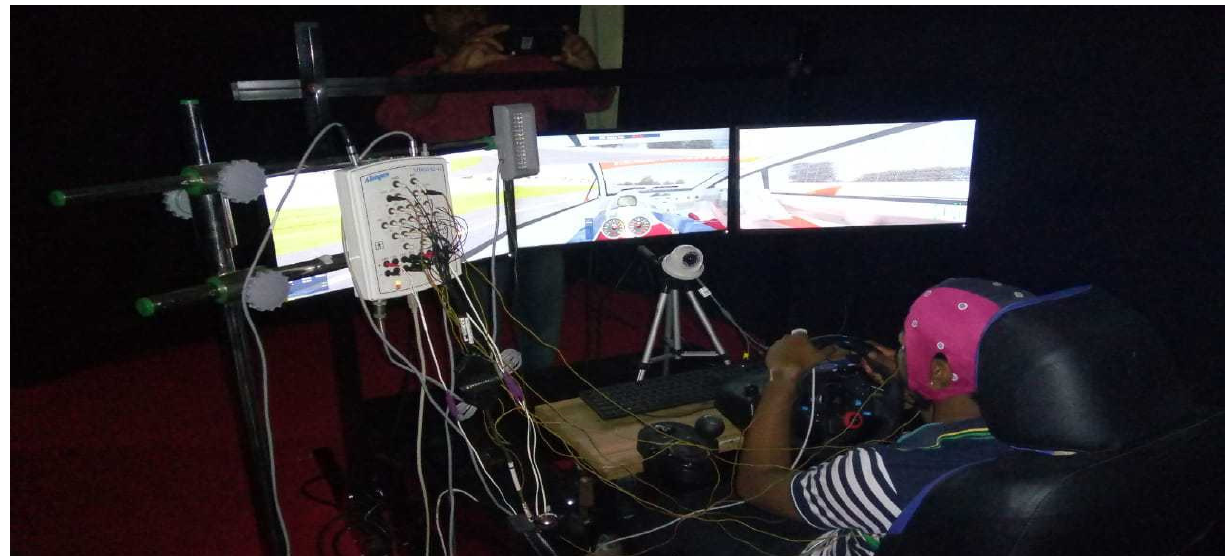
Figure 2 . Experimental setup. Figure 2. Experimental setup.